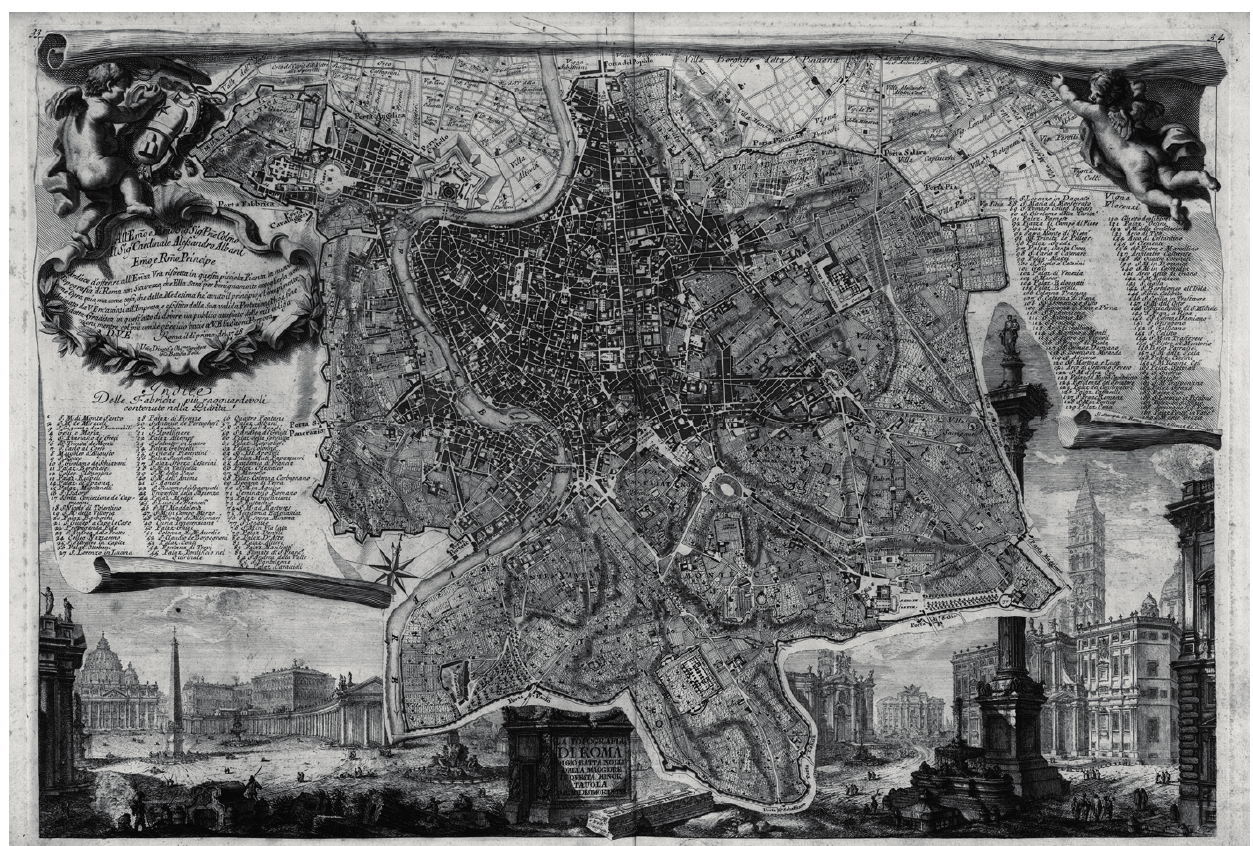
Figure 1. Nuova pianta di Roma by G.B. Nolli,